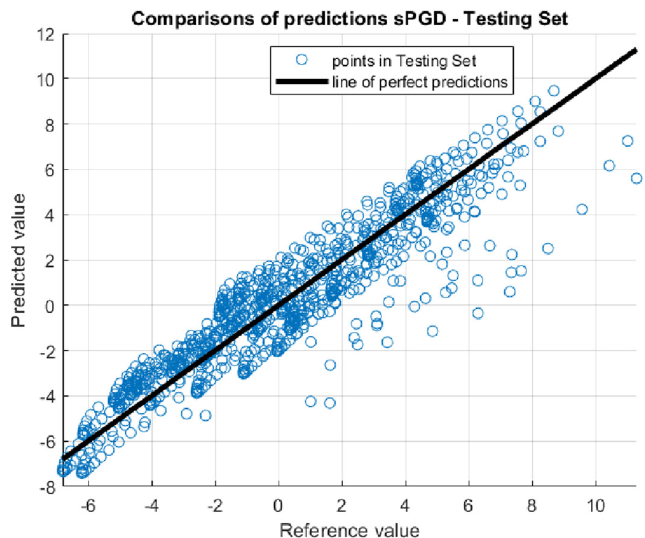
Fig. 13 Comparing s -PGD and ANOVA-PGD regressions